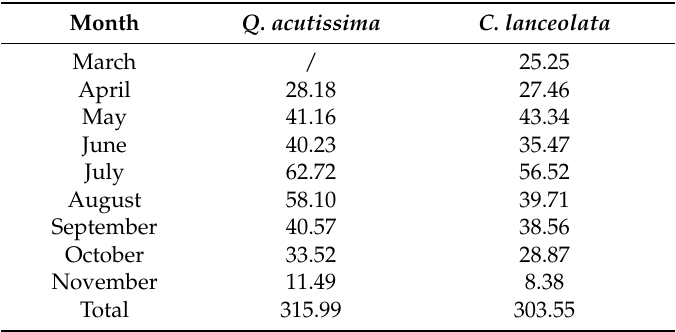
Table 4. The canopy transpiration of the stands from March–November